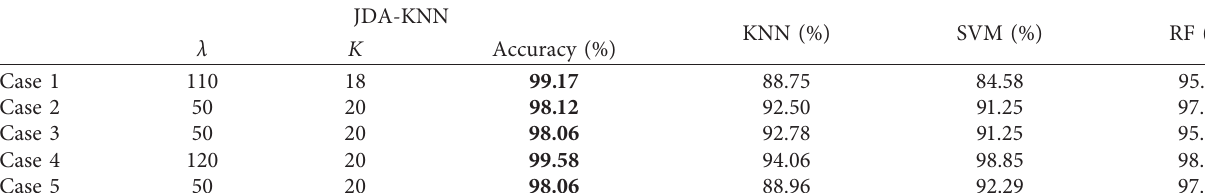
Table 4: Diagnosis results of Cases 1–5 by using JDA-KNN, KNN, SVM, and RF.